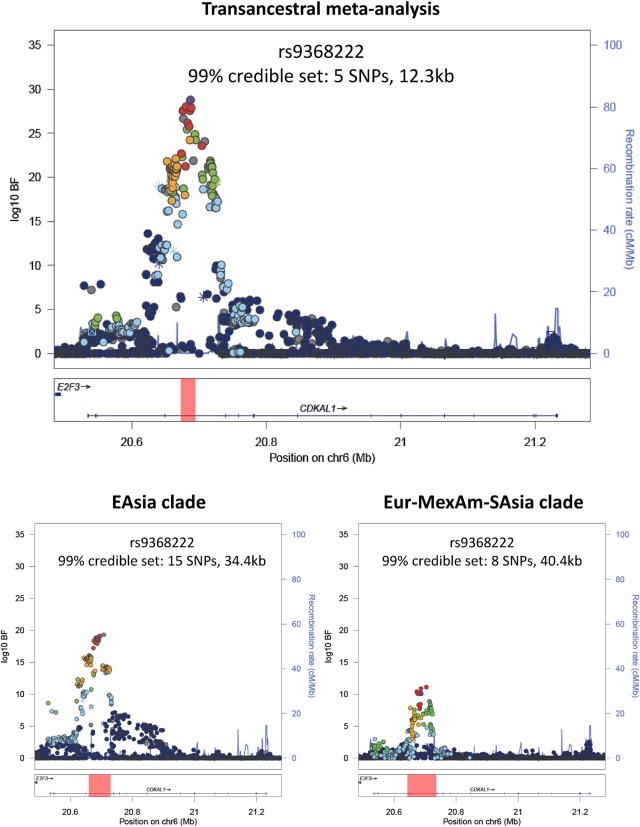
Fine-mapping of the association signal at the CDKAL1 locus on the basis of transancestral meta-analysis of GWAS from all ancestry groups (top) and GWAS in the EAsia and Eur-MexAm-SAsia ancestral clades only (bottom). Each point represents a SNP passing quality control in the transancestral meta-analysis, plotted with their log10BF as a function of genomic position (NCBI Build 37). In each plot, the index SNP is represented by the purple symbol. The colour coding of all other SNPs indicates LD with the index SNP (estimated from 1000 Genomes Project reference haplotypes by EUR r2 for the transancestral meta-analysis and Eur-Mex-SAsia clade, and by ASN r2 for the EAsia clade): red r2 ≥ 0.8; gold 0.6 ≤ r2 < 0.8; green 0.4 ≤ r2 < 0.6; cyan 0.2 ≤ r2 < 0.4; blue r2 < 0.2; grey r2 unknown. The shape of the plotting symbol corresponds to the annotation of the SNP: upward triangle for framestop or splice; downward triangle for non-synonymous; square for synonymous or UTR; and circle for intronic or non-coding. Recombination rates are estimated from Phase II HapMap and gene annotations are taken from the UCSC genome browser. The genomic interval covered by the 99% credible set of variants for the association signal from the transancestral and ancestry-specific meta-analyses are highlighted by the red bar.